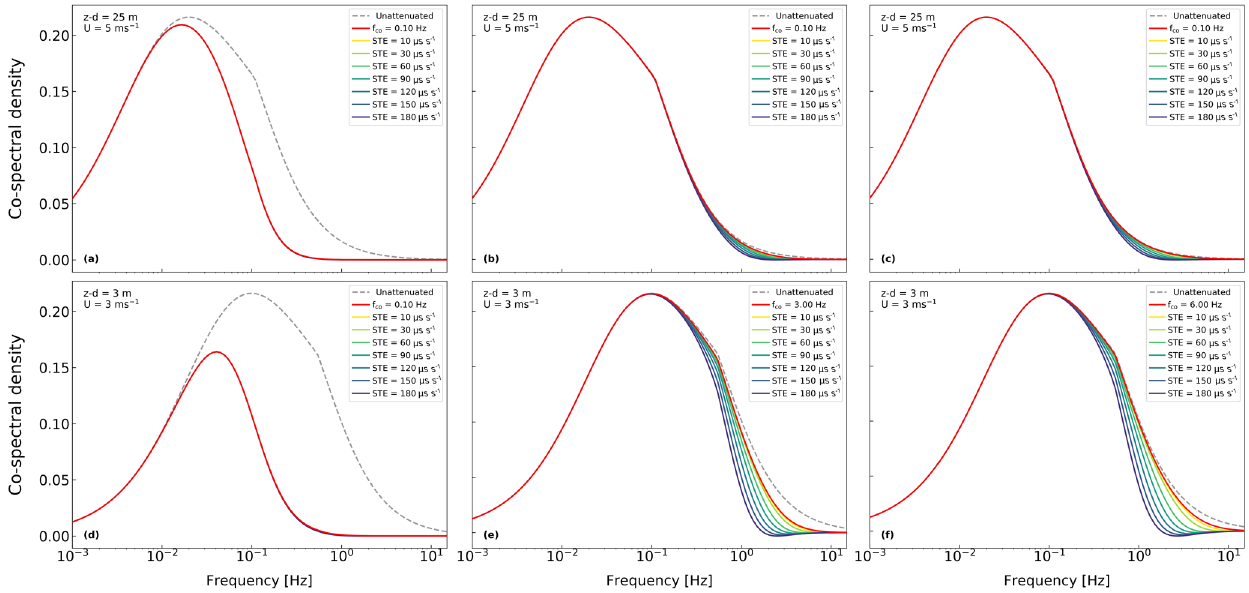
Figure 7. Effect of adding artificial STEs to three EC systems characterized by different cutoff frequencies (0.1, 3.0, and 6.0Hz for d , e , and f , respectively) and by different measurement height and mean wind speed (from a–c to d–f